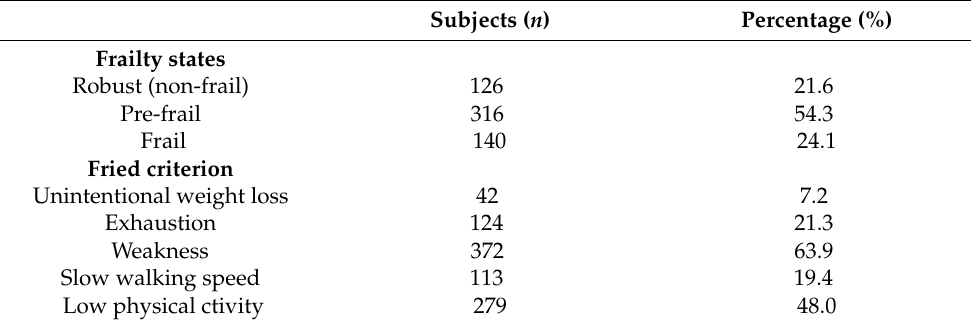
Table 2. Frailty states and criteria according to Fried’s phenotype ( n = 582).